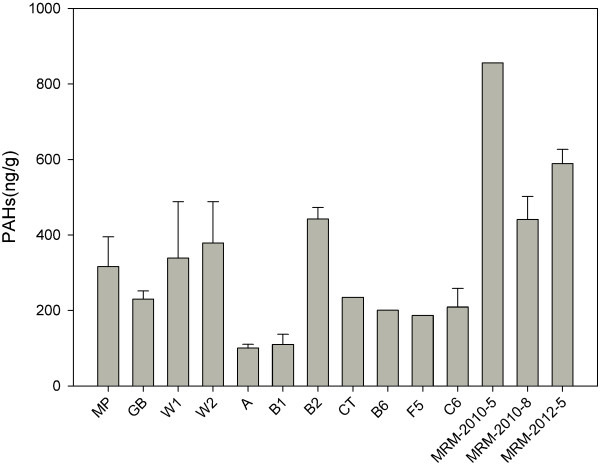
Total PAH concentrations in sediments from northern Gulf of Mexico. Error bars represent one standard deviation of duplicate samples.